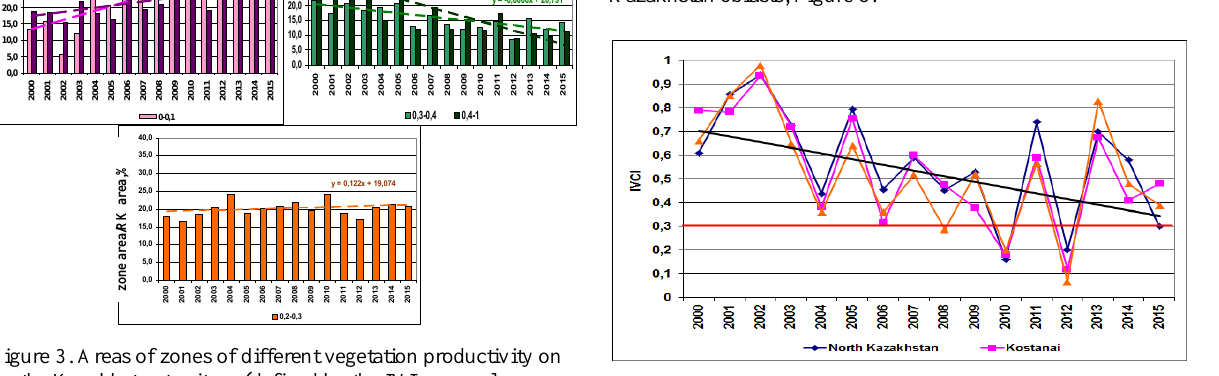
Figure 5. Dynamics of the integral index of vegetation conditions on crop main oblasts of Kazakhstan for the period